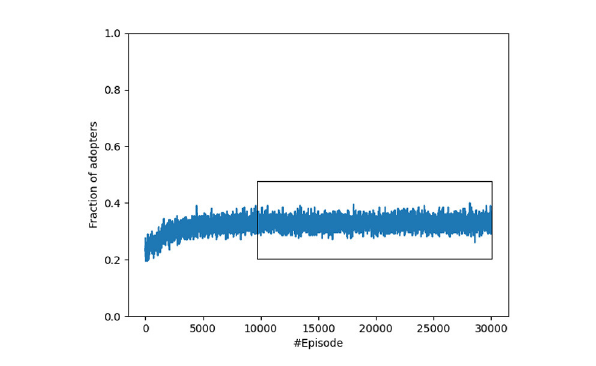
FIGURE6 Fraction of adopters reached at the end of each simulation episode with the stable training period marked with a box.